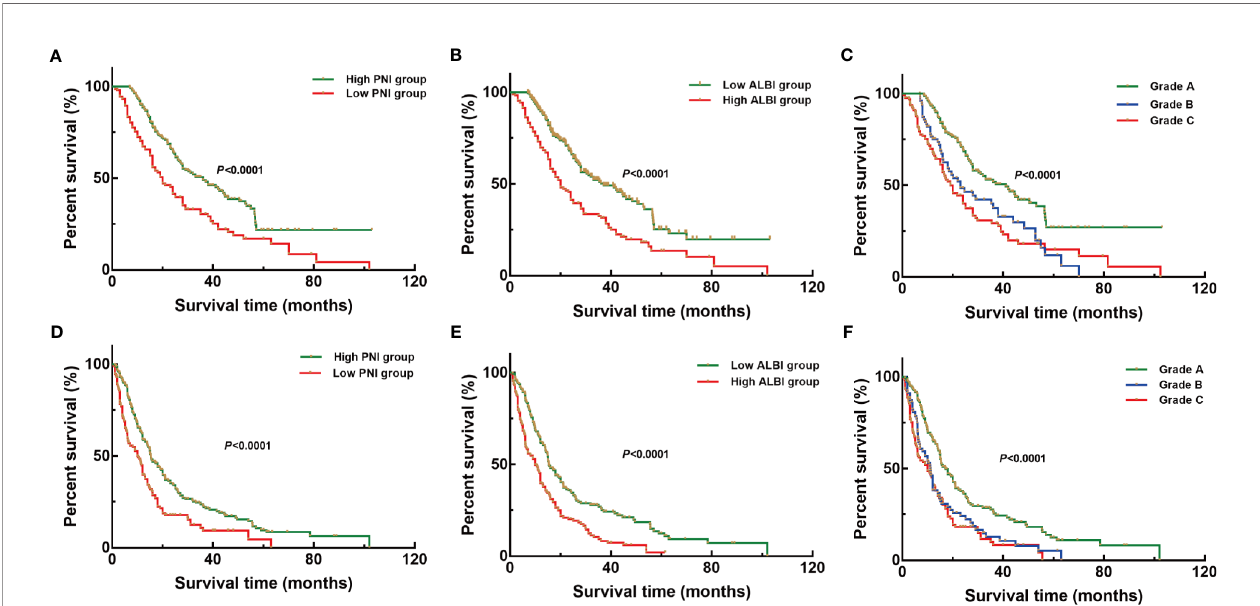
FIGURE 1 | Kaplan – Meier overall survival (OS) and recurrence-free survival (RFS) curves of patients with intrahepatic cholangiocarcinoma (ICC) after radical resection according to different prognostic factors in the training set. (A – C) Kaplan – Meier OS curves according to the prognostic nutritional index (PNI) (A) , albumin – bilirubin (ALBI) (B) , and PNI+ALBI grade (C) . (D – F) Kaplan – Meier RFS curves according to the PNI (D) , ALBI (E) , and PNI+ALBI grade (F) .